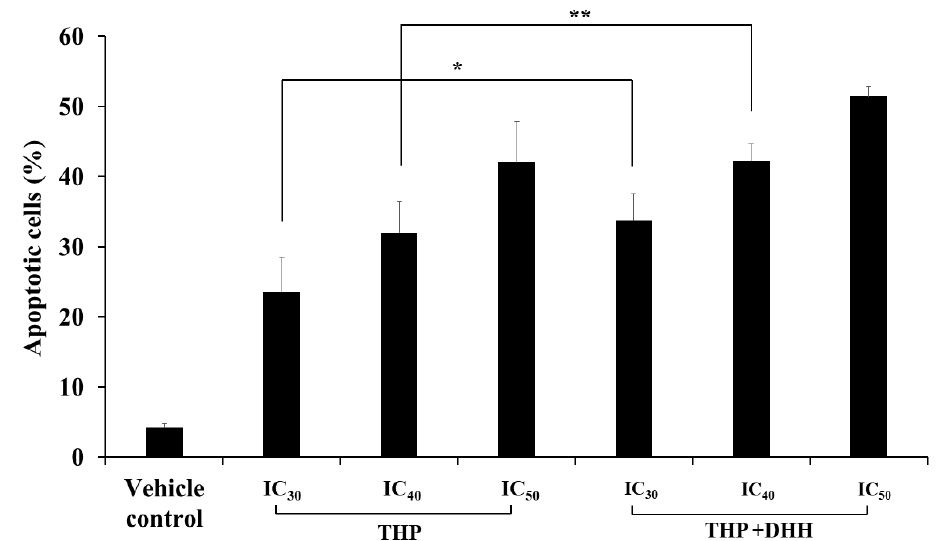
Figure 11. Effects of THP and THP combined with DHH on apoptosis induction in K562/ADR cells. K562/ADR cells (1.0 × 10 5 cells/mL) were cultured with various concentrations of THP or 55.6 µM of DHH in the presence of different concentrations of THP. Apoptotic cells were determined by staining with PI and Annexin V-FITC. The percentage of apoptotic cells were compared. The data are shown as mean ± SD from three independent experiment. The significance of mean differences was assessed using one-way ANOVA. * p < 0.05 as compared with THP treatment at IC 30 . ** p < 0.01 as compared with THP treatment at IC 40 .